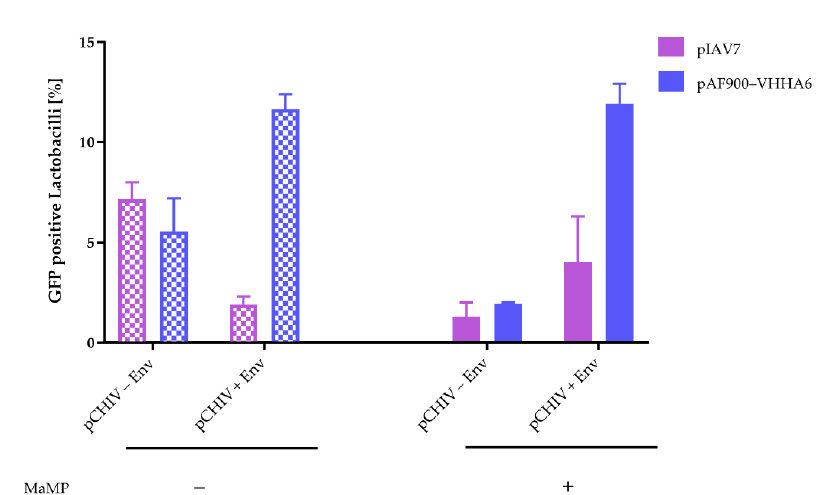
Figure 5. Reduction in background binding of GFP-labeled HIV-1 virus particles lacking Env to Lactobacilli by Methyl- α -D-mannopyranoside (MaMP) analyzed by flow cytometry. The addition of MaMP (0.05 M, right panel) reduces background binding of GFP-labeled HIV-1 virus particles lacking Env (pCHIV − Env) to L. rhamnosus DSM14870 expressing VHHA6 on the surface (pAF900-VHHA6, blue) or not (pIAV7, purple). MaMP has no e ff ect on specific binding of NL4-3 viral particles with Env (pCHIV + Env) to lactobacilli expressing VHHA6 (blue: 12.4% compared to 11.9%) and only marginally increases binding to wildtype Lactobacilli (purple: 2.3% compared to 4.1%). Error bars represent SEM of two